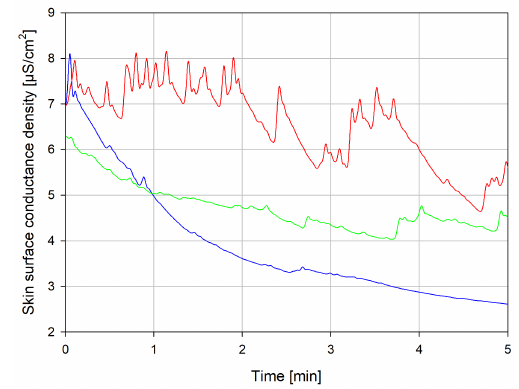
Figure 1: Example measurement of low frequency skin conductance. Person being highly stressed (red curve), moderately stressed (green curve), and totally relaxed (blue curve).